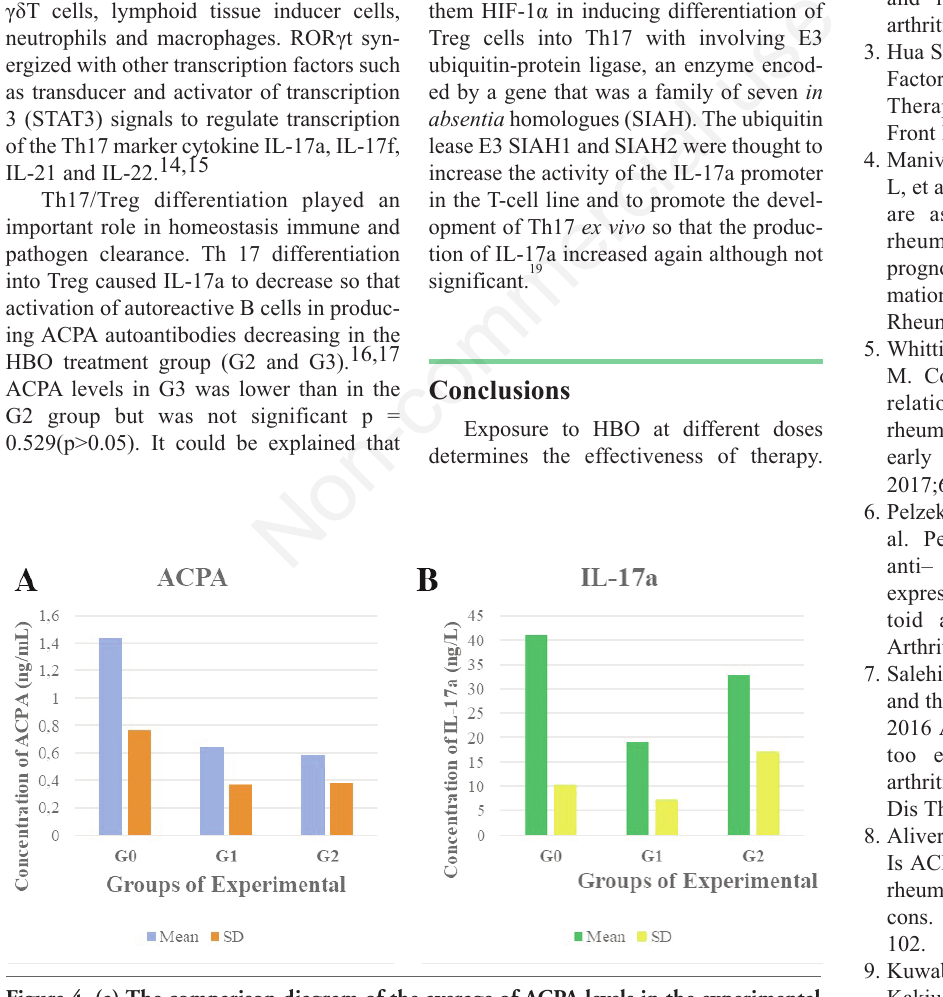
Figure 4. (a) The comparison diagram of the average of ACPA levels in the experimental groups. (b) The comparison diagram of the average IL-17a levels in the experimental